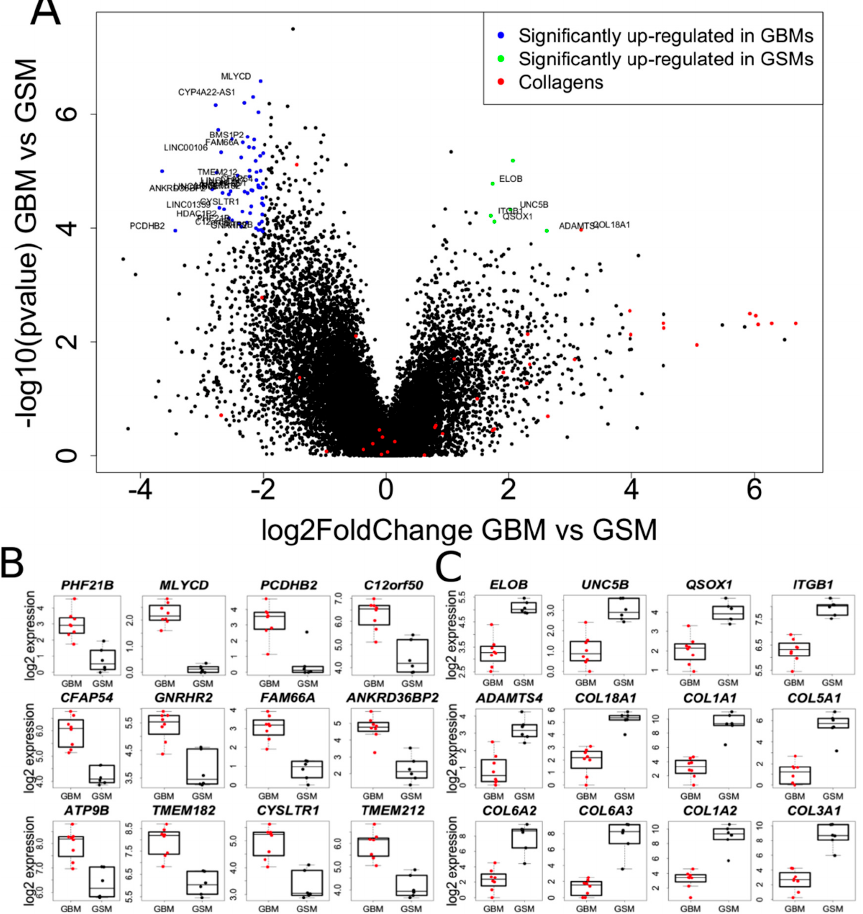
Figure 4. Characterization of gliosarcoma transcriptomes and comparison to glioblastoma (GBM). ( A ) Volcano plot of gene expression shows the differences between GBM and gliosarcoma. X axis depicts the significance of expression change (more distant from 0 being more significant) and Y axis depicts log2 fold change. Genes significantly up-regulated in GBM are color-coded in blue, while genes up-regulated in gliosarcoma are color-coded in green, collagen coding genes are color-coded in red. The threshold for color-coded genes where: log2FoldChange higher than 1.5 or lower than 0.5 and false discovery rate (FDR) adjusted p-value lower than 0.01. ( B ) Boxplot of selected genes that were down-regulated in gliosarcomas when compared to GBMs. ( C ) Boxplot of selected genes that were up-regulated in gliosarcomas when compared to GBMs with a special emphasis on collagens showing high fold difference between gliosarcomas and